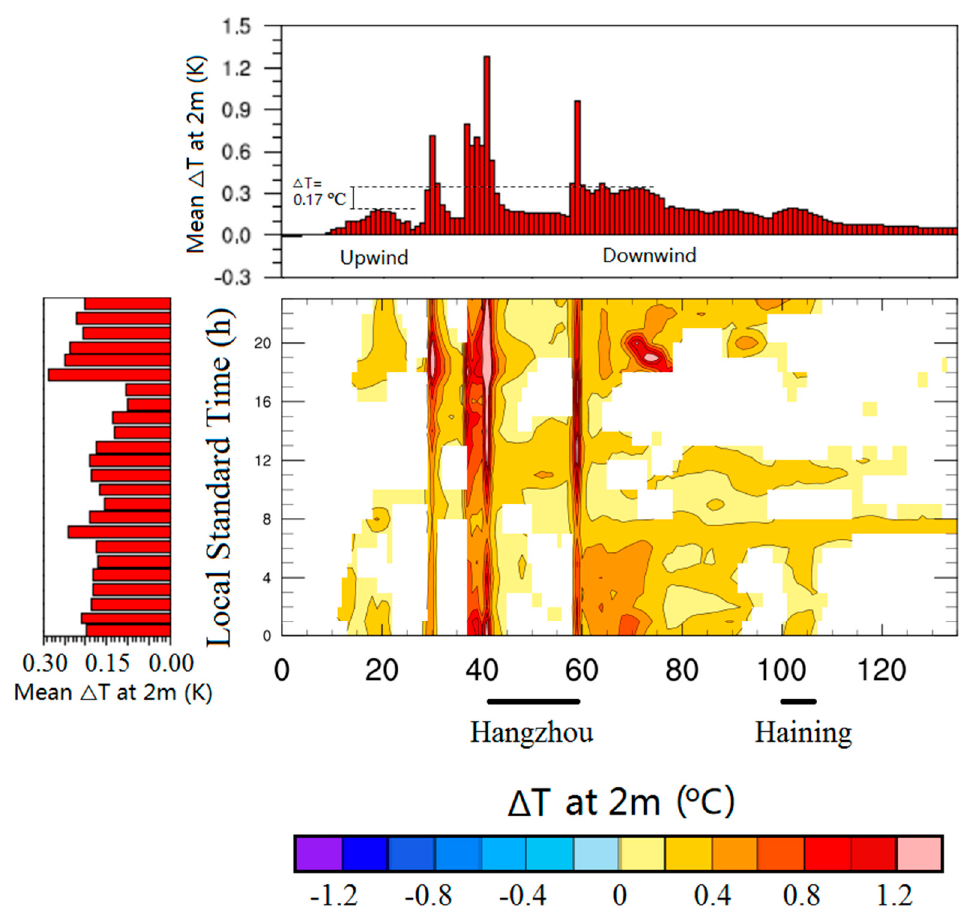
Figure 9. Mean (2–5 July 2013 LST) diurnal 2 m air temperature difference (in K) between the UE 0.5 and UE 1.0 scenarios (Section 2.5) along line AB (see Figure 3a). The values between − 0.1 °C and 0.1 °C are masked.